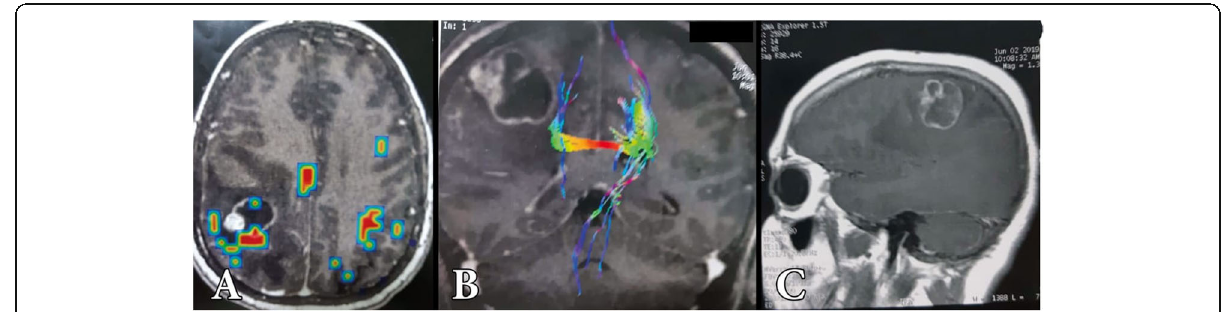
Fig. 5 Preoperative axial bold ( A ), coronal tractography ( B ), and sagittal post-contrast MRI images of a 32-year-old female patient presented by seizures and hemiparesis grade 4 history of cancer ovary with oopherectomy and hysterectomy since 2